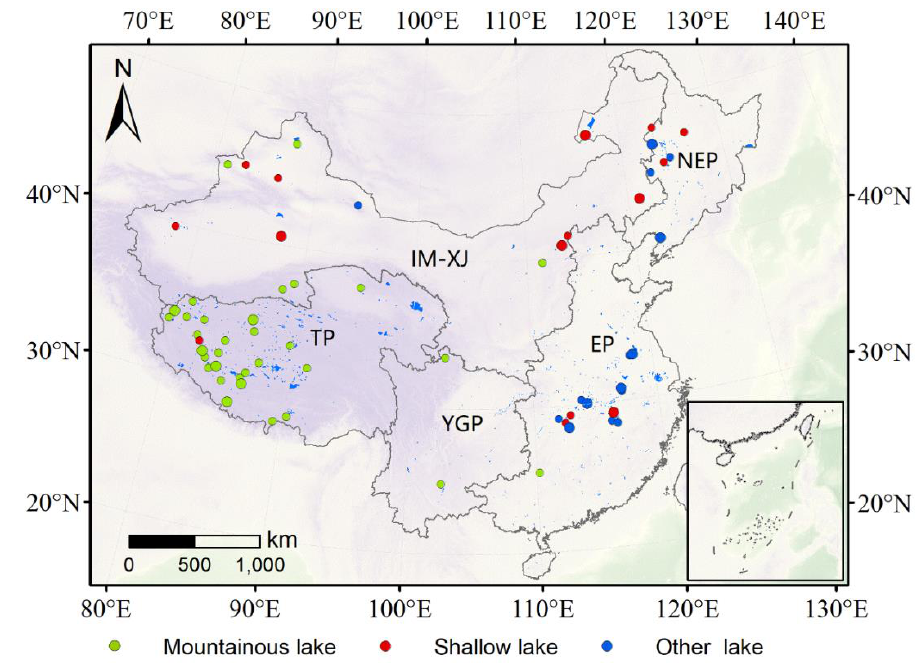
Figure 8. Distribution of lakes with non-horizontal LSH profiles (MSD > 0.05 m). Lakes with moderate MSDs (0.05~0.10 m) are marked with smaller dots, and lakes with great MSDs ( > 0.10 m) are marked with greater dots.